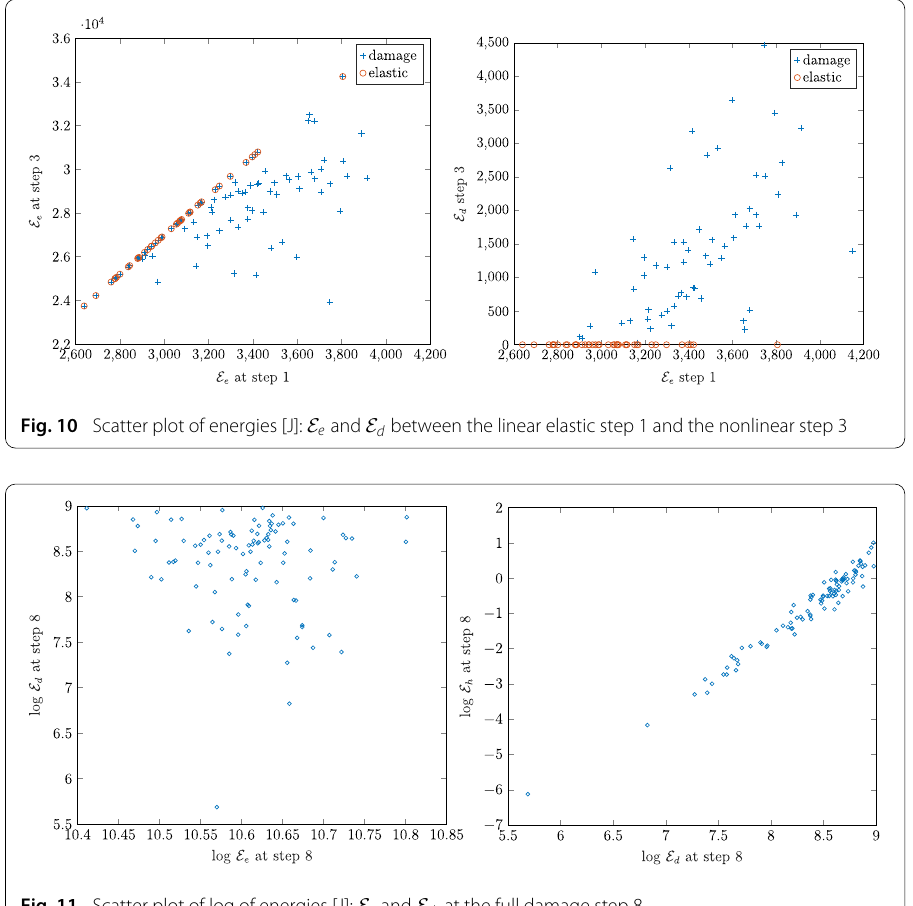
Fig. 11 Scatter plot of log of energies [J]: E e and E d , at the full damage step